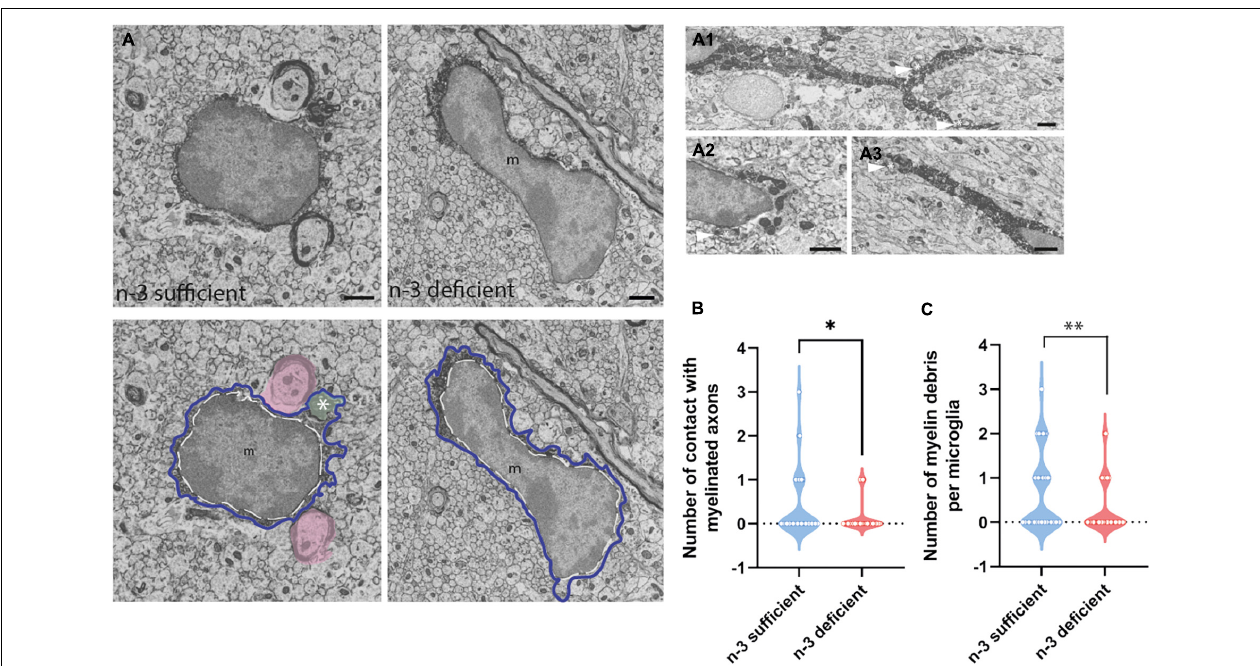
FIGURE 2 | N-3 PUFA deficiency reduces the number of contacts between microglia and myelin axon and decreases the presence of myelin fragments in microglia. (A) Representative images of microglial ultrastructure in the corpus callosum of P10 mice (left panel: n-3 sufficient, right panel: n-3 deficient; upper panels: original images, lower panels: with false colors), showing interactions between microglial cell bodies and myelinated axons (in pink), as well as myelin debris (green, see asterisk) in the cytoplasm of the cell (magnification: 10,000 × ) (scale bar = 1 µ m). More examples of microglia engulfing myelin debris (see asterisk and arrowhead) in A1–A3; Scale bar = 1 µ m. Microglia are annotated with “m,” the contour of their nucleus is delineated with a white dotted line and the cytoplasm by a purple line. (B) Quantification of the number of myelinated axons in contact with microglia in both dietary groups. (C) Quantification of number of myelin debris in microglial cells, in both dietary groups. All data are presented as mean ± SEM. n = 63–65 microglia/group, N = 6